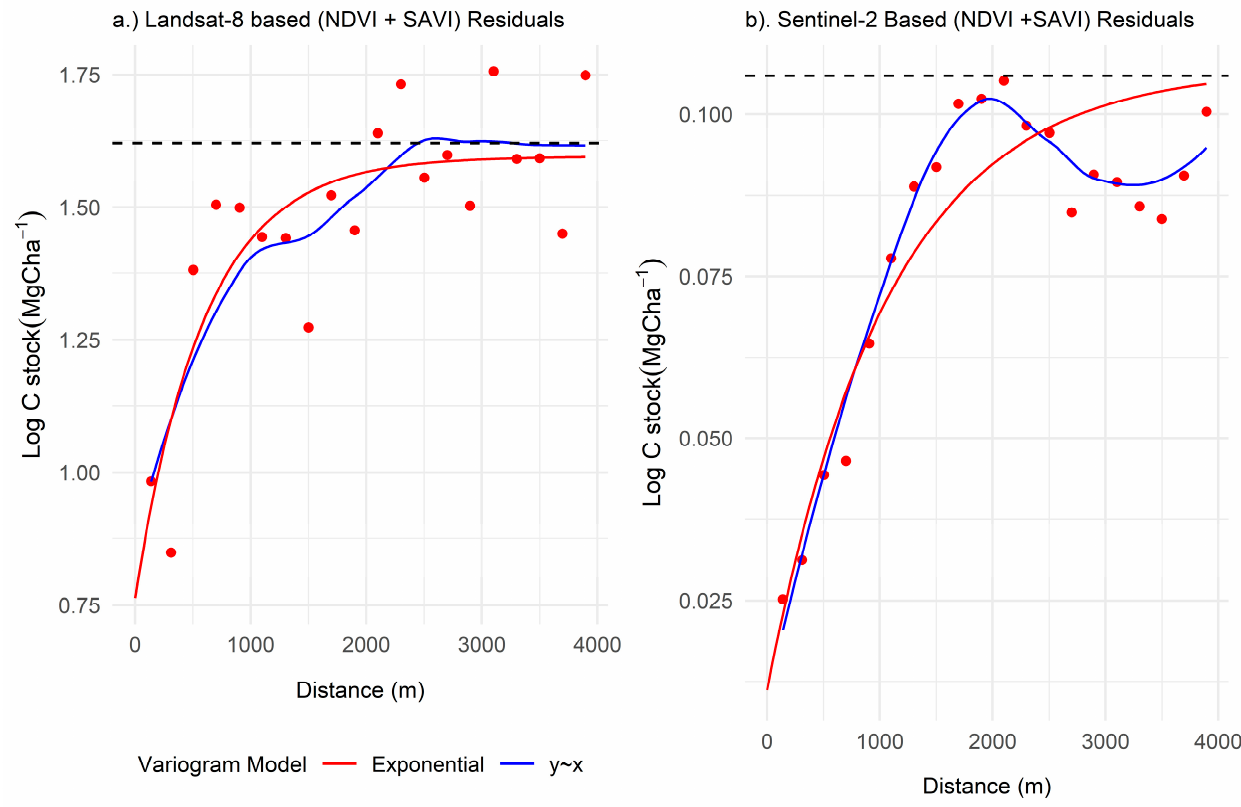
Figure 3. Variogram modelling for Landsat-2- and Sentinel-2-derived vegetation indices. The asymptote for the theoretical variogram model is shown by the black dotted line.